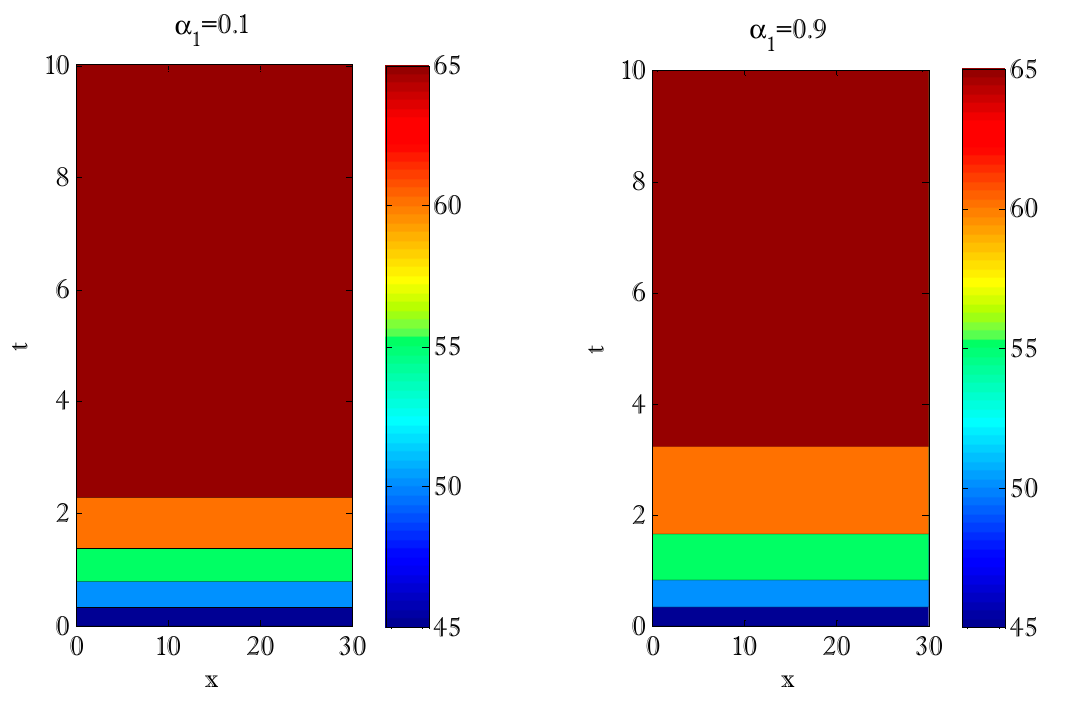
Figure 10. Impact of the bilinear incidence rate parameter α 1 on recovered individuals using N x = 50, N t = 300, β = 0.9, γ = 0.7, σ = 0.9, µ = 0.9, d 1 = 2, d 2 = 2.5, d 3 = 2.5, d 4 = 2, d 5 = 2, α = 0.9.